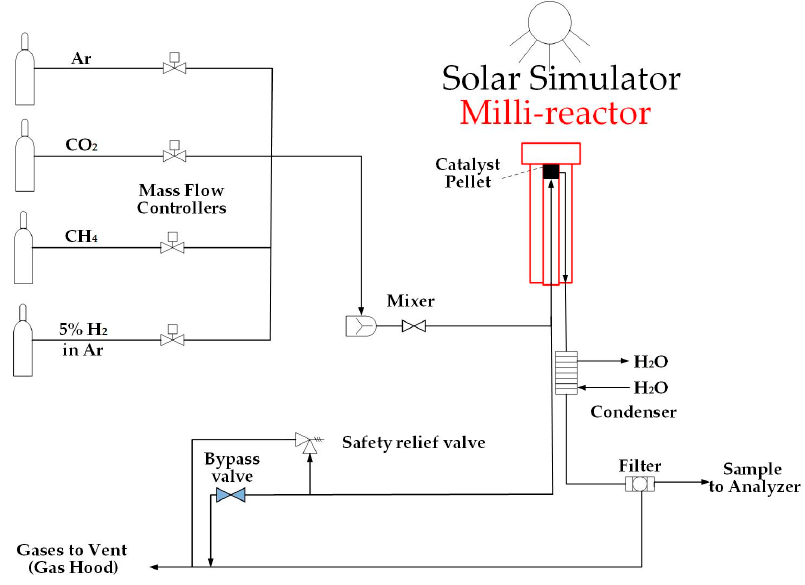
Figure 6. Schematic of the experimental apparatus.